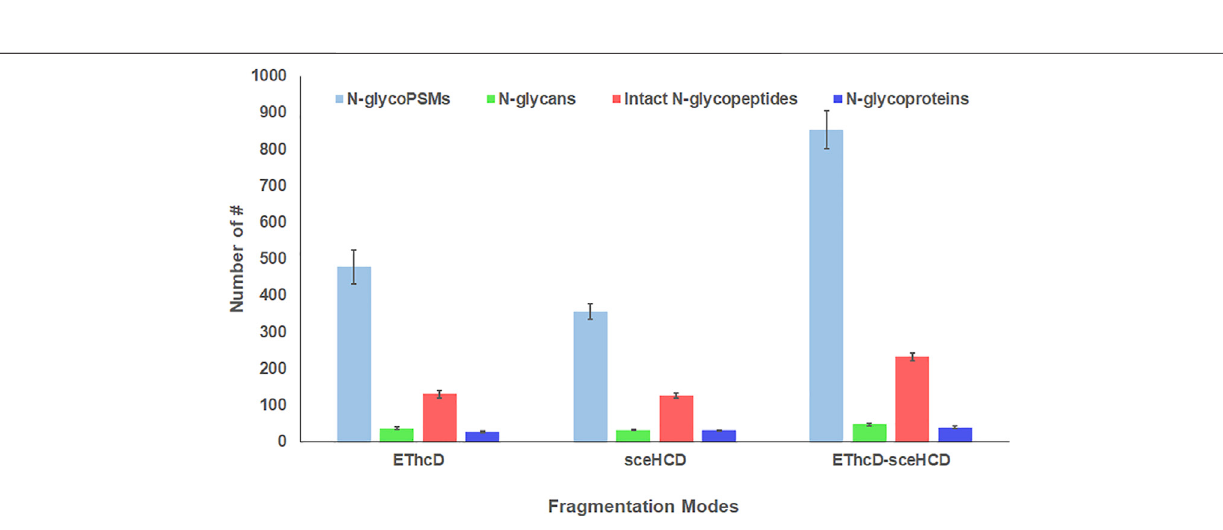
FIGURE2| ComparisonofthenumberofN-glycoPSMs,N-glycans,intactN-glycopeptides,andN-glycoproteinsfrompooledPCapatients ’ plasmausingdifferent dissociation methods. (ANOVA was used for the statistical comparison among three groups, and Student ’ s t -test was used for the statistical comparison between two groups. The homogeneity test was performed. The error bar denotes